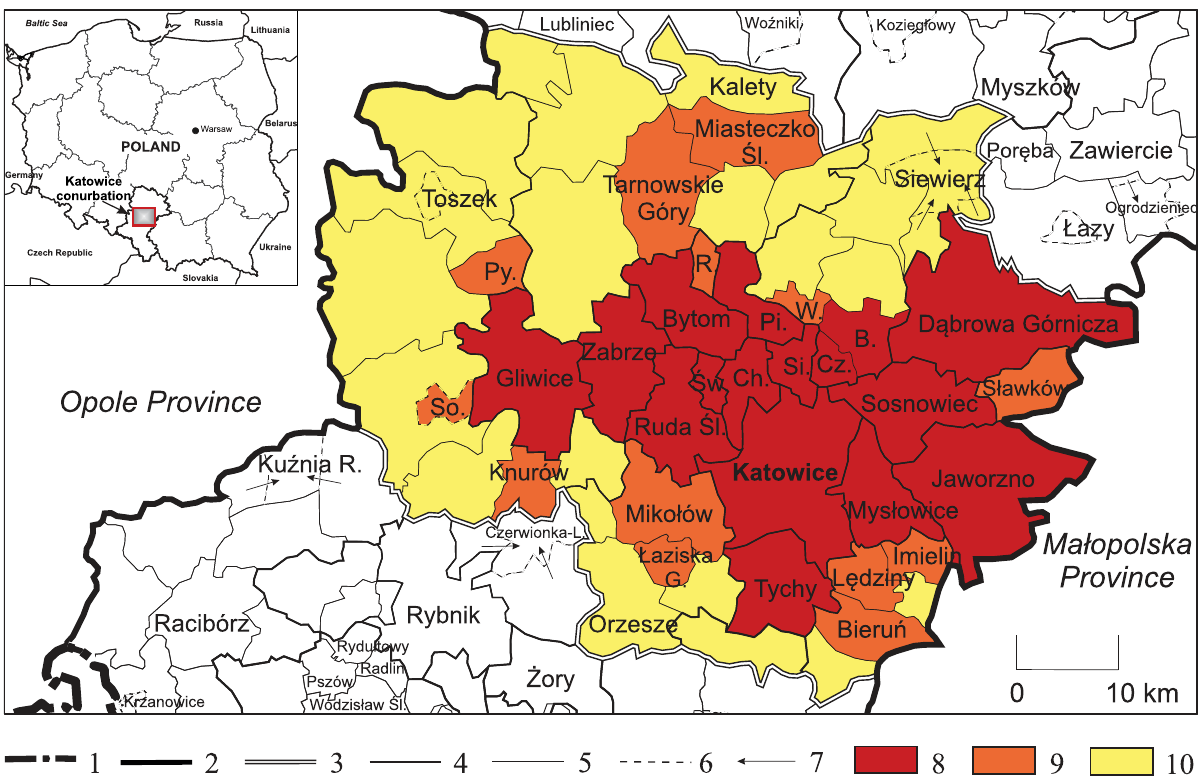
Fig. 1. The area of the Katowice conurbation, Poland (Source: own elaboration based on Krzysztofik, 2007;, Runge et al., 2011b; Spórna,